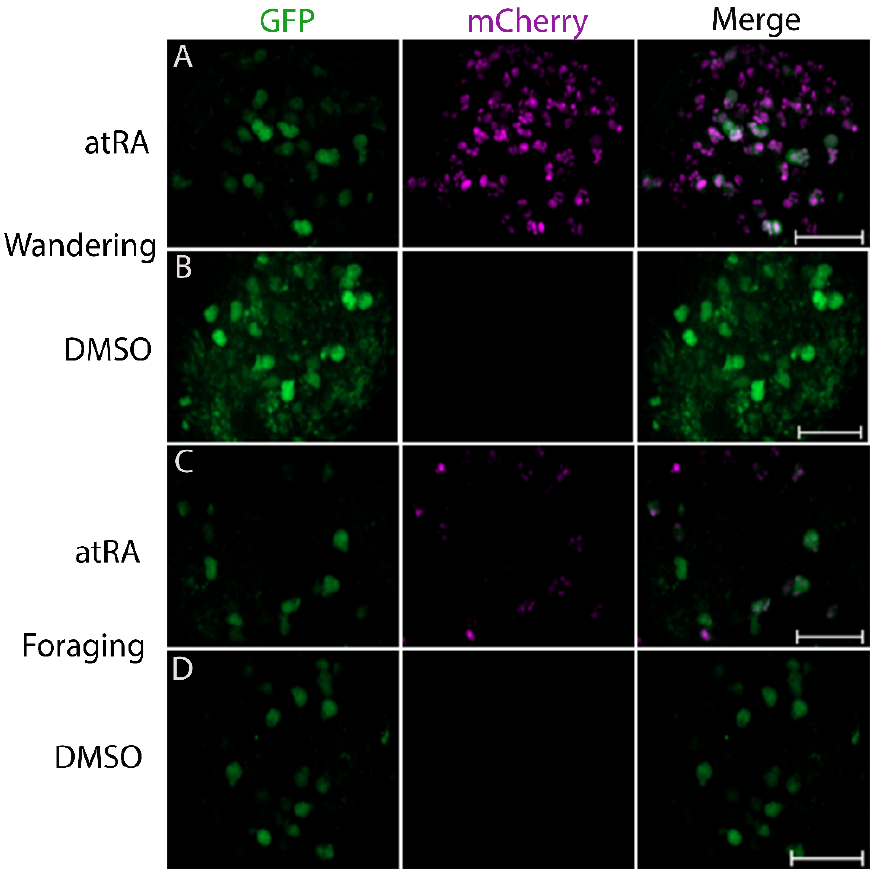
Figure 2. Activation of the LymRXR sensor by 10 μ M all- trans RA. Representative examples of Drosophila CNS (individual hemispheres) exposed to either 0.1% DMSO ( B , D ) or 10 μ M all -trans RA (atRA) ( A , C ) in either wandering (top panels) or foraging (lower panels) larvae following heat-shock. Images show sensor expression levels (GFP only), transcriptional activity of the sensor (mCherry only), and a merged representation. Though there are no significant differences in GFP levels, mCherry levels are clearly elevated following exposure to 10 μ M atRA. Scale bars: 50 μ m.